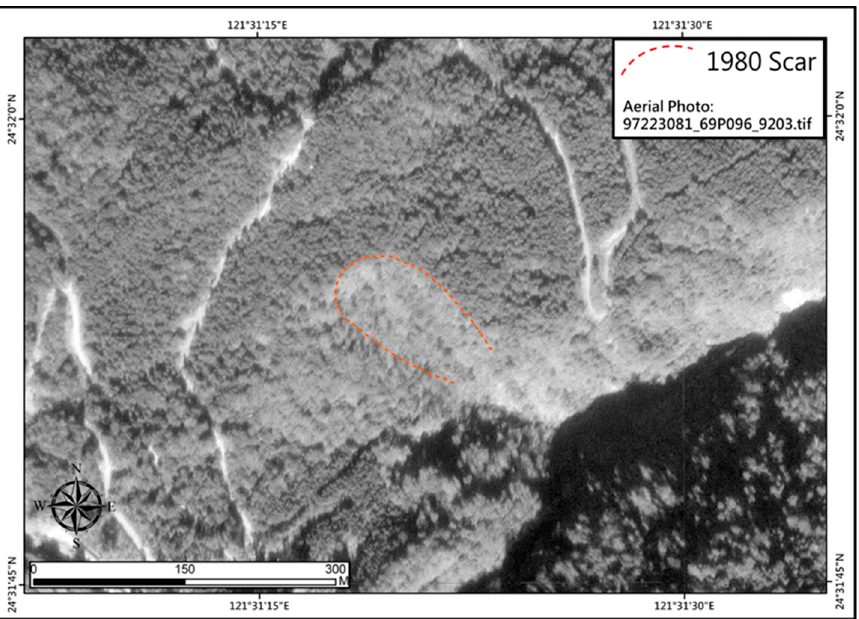
Figure 6. The first aerial photo image record of the deep-seated landslide of the study area taken on 30th November 1980 (WGS 84 coordinates). The bare ground exposed due to landslide is marked with the red dash line, and some vegetation recover can be observed.